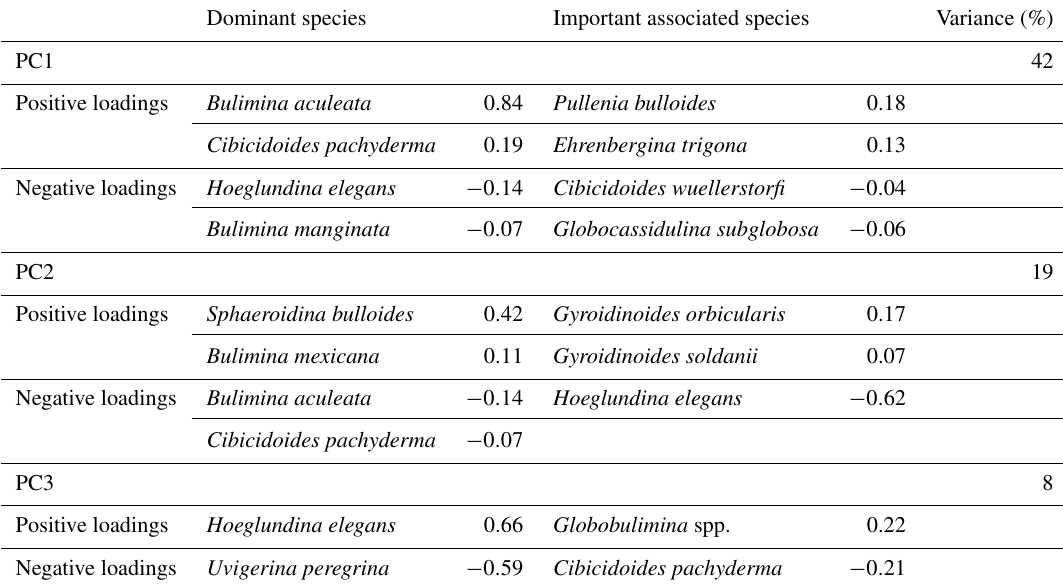
Table 1. Species composition of benthic foraminiferal assemblages from core MD77-191. Dominant